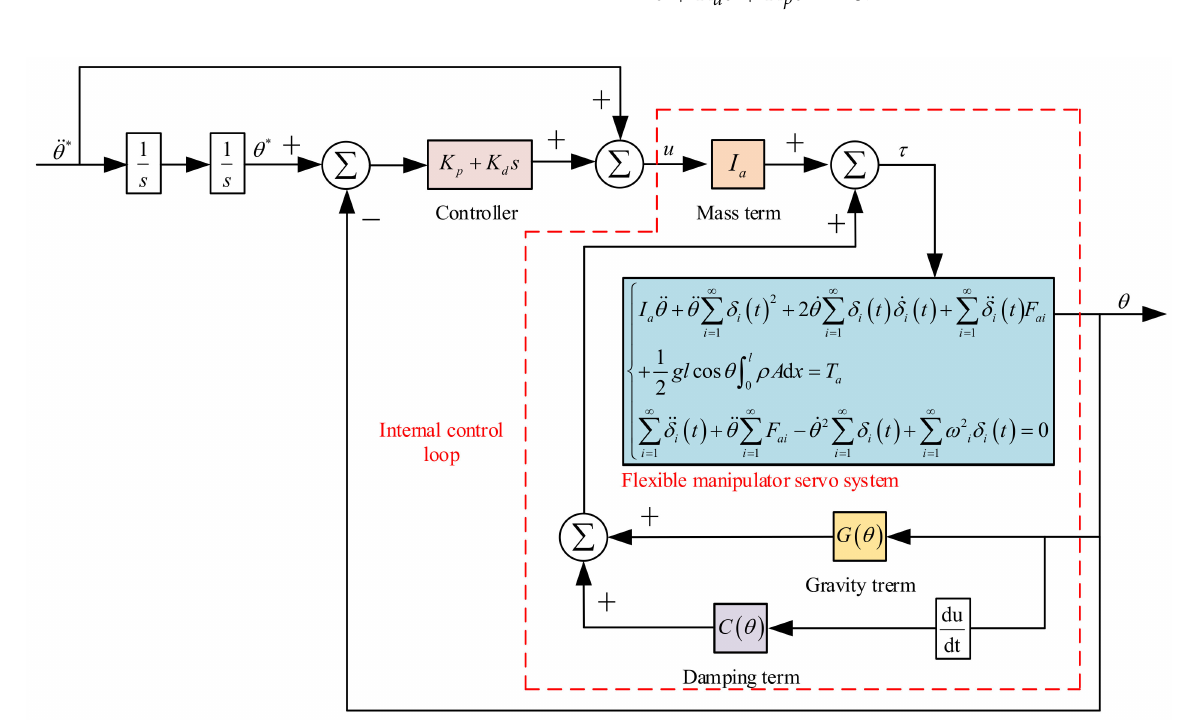
Figure 6. The internal control loop of the servo system for flexible